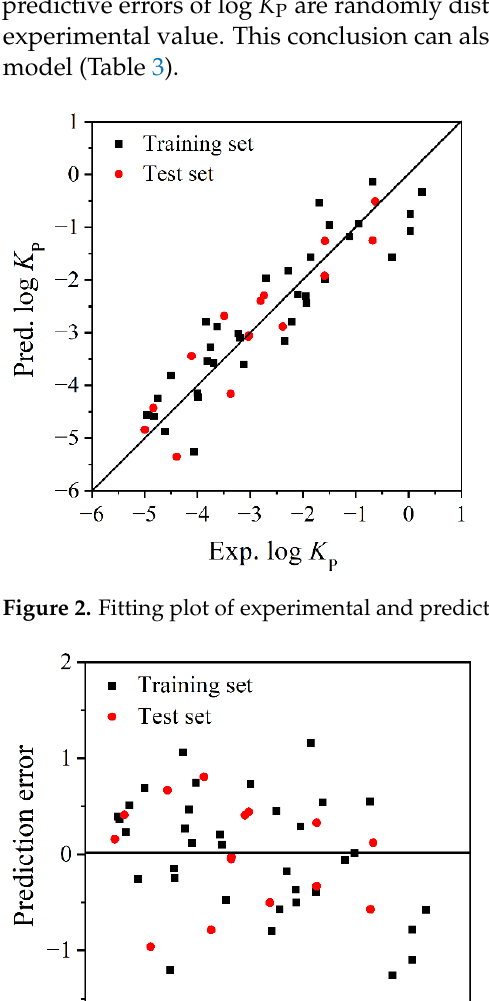
P errors by MLR